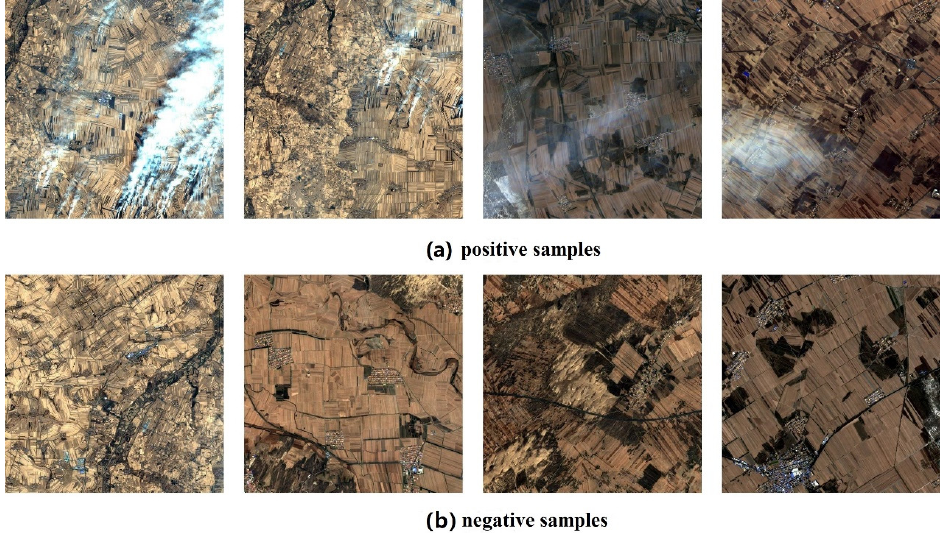
Figure 2. Sample of ( a ) positive and ( b ) negative images.